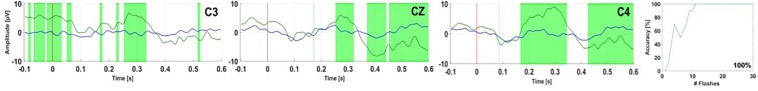
EPs and accuracy for healthy control HC 6 over electrodes C3, Cz, and C4 (Spataro et al., 2018). In each EP plot, the red line shows stimulus onset, the blue line shows EPs from non-target trials, and the green line shows the EPs from target trials. Green shaded areas are time regions with statistically significant differences between target vs. non-target trials (p < 0.05). The figure to the right of the EP plots shows the classification accuracy over the number of target events. This figure presents the median accuracy.